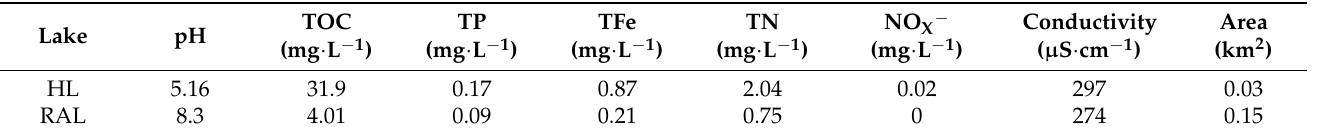
Table 1. Physical and chemical properties for the HL and the RAL. pH, TOC, TP, TFe, TN, NO x − , conductivity, and area.